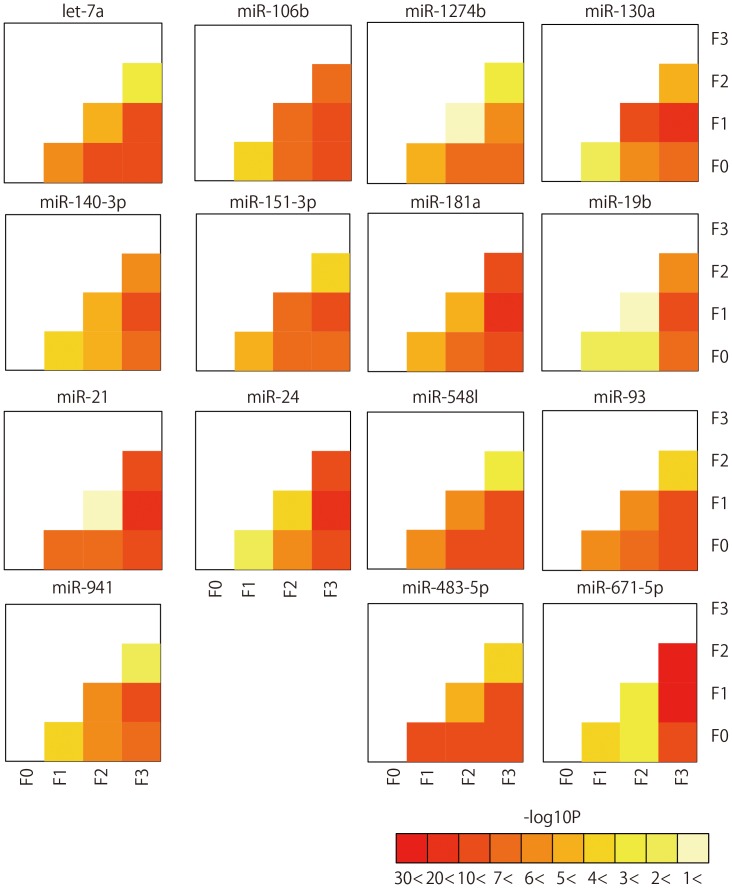
Significantly differentially expressed miRNA according to liver fibrotic stage.Pairwise heatmap showing the miRNAs and p-value of two arbitrary stages.